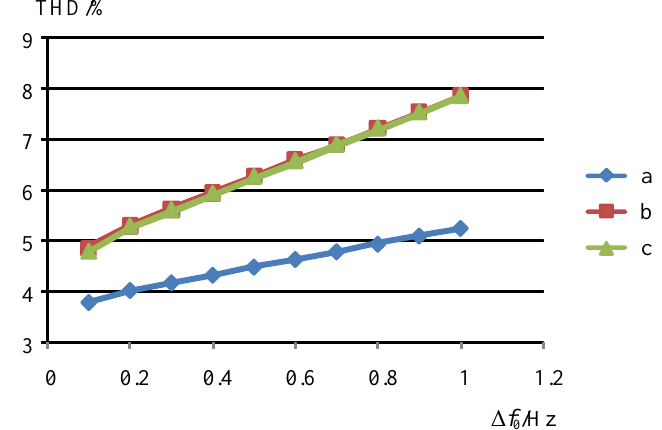
Figure 14. The change of three-phase THDs with different frequency disturbances.